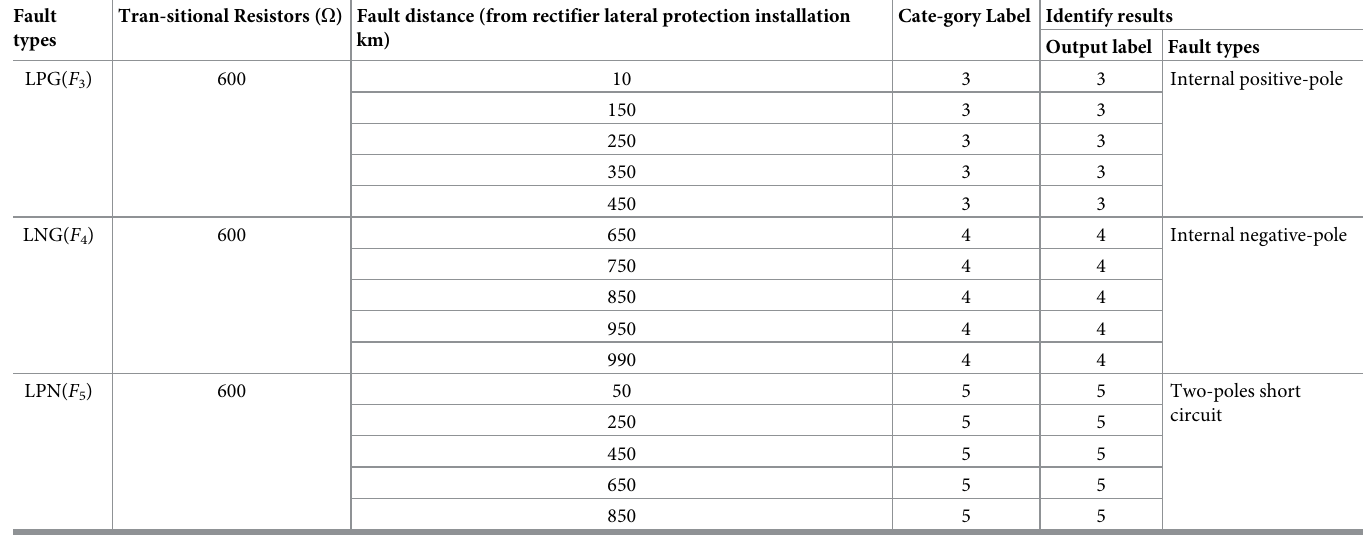
Table 6. Simulation verification results when faults occur at different